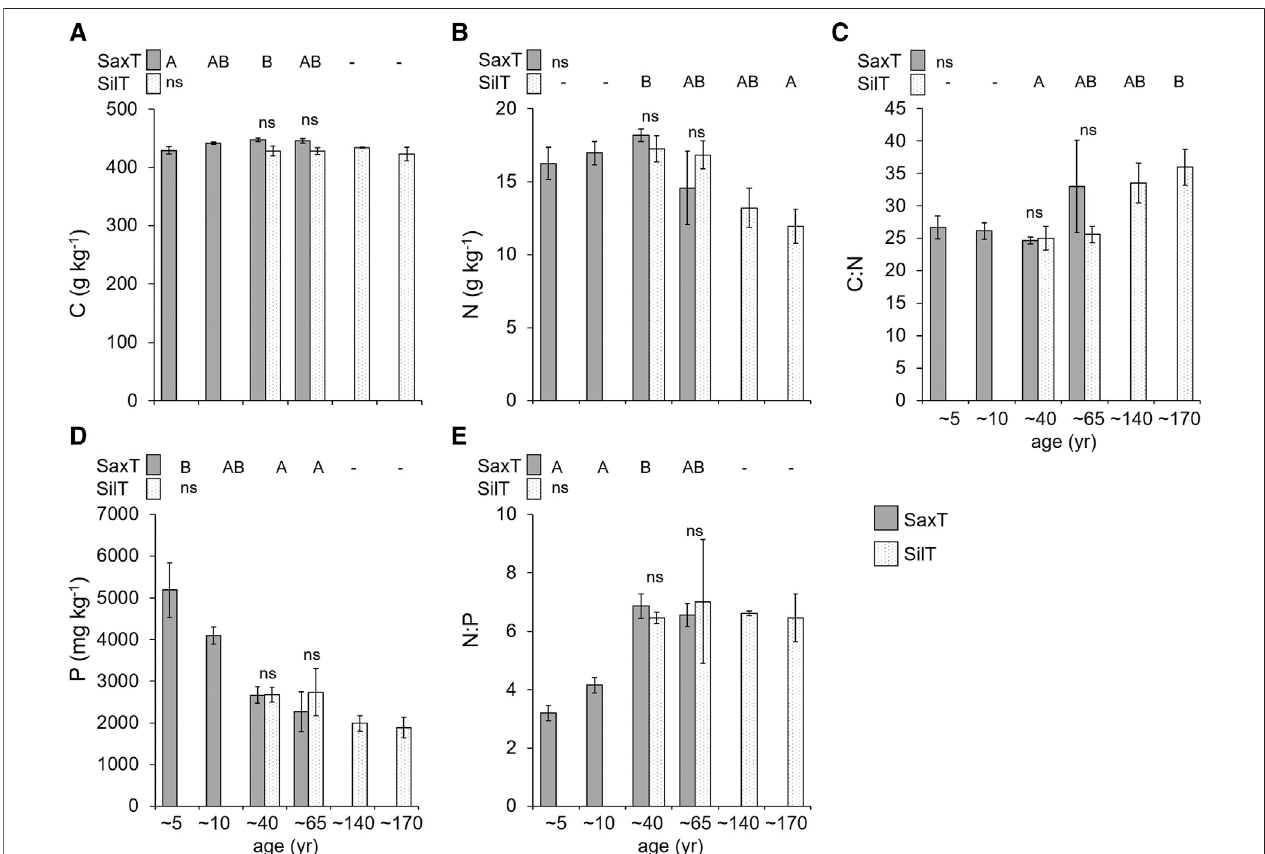
FIGURE 6 | Chemical properties of plant tissues for the target species along the six stages of the chronosequence. SaxT, Saxifraga oppositifolia L. subsp. glandulifera Vacc. L. tissues; SilT, Silene acaulis (L.) Jacq subsp. bryoides (Jord.) Nyman tissues; C, carbon (A) ; N, nitrogen (B) ; C :N, carbon to nitrogen ratio (C) ; P, phosphorus (D) ; N:P, nitrogen to phosphorus ratio (E) . Different letters indicate signi fi cant differences ( p < 0.05) among stages within each target species (uppercase letters) and between target species within each stage (lowercase letters) according to Tukey ’ s HSD test. ns, p ≥